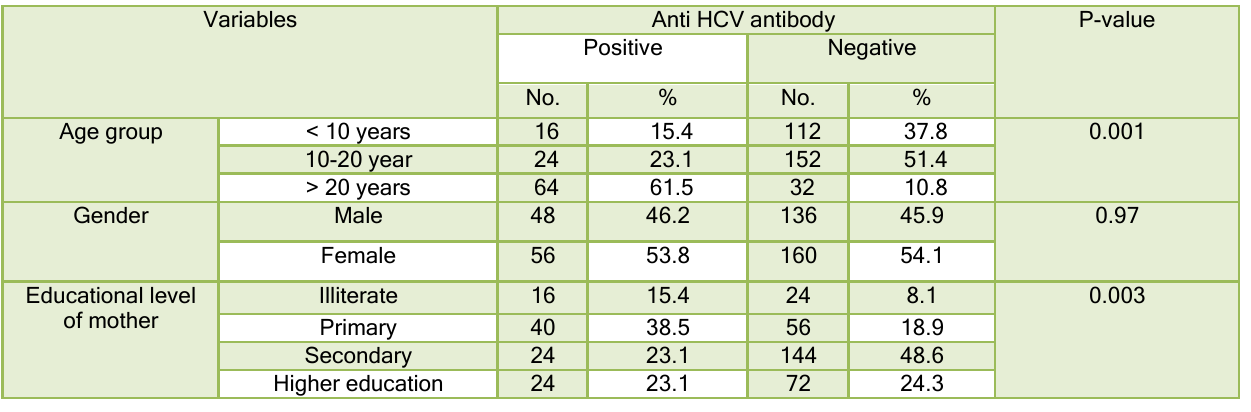
Table 1: Demographic characteristics of HCV positive thalassemic